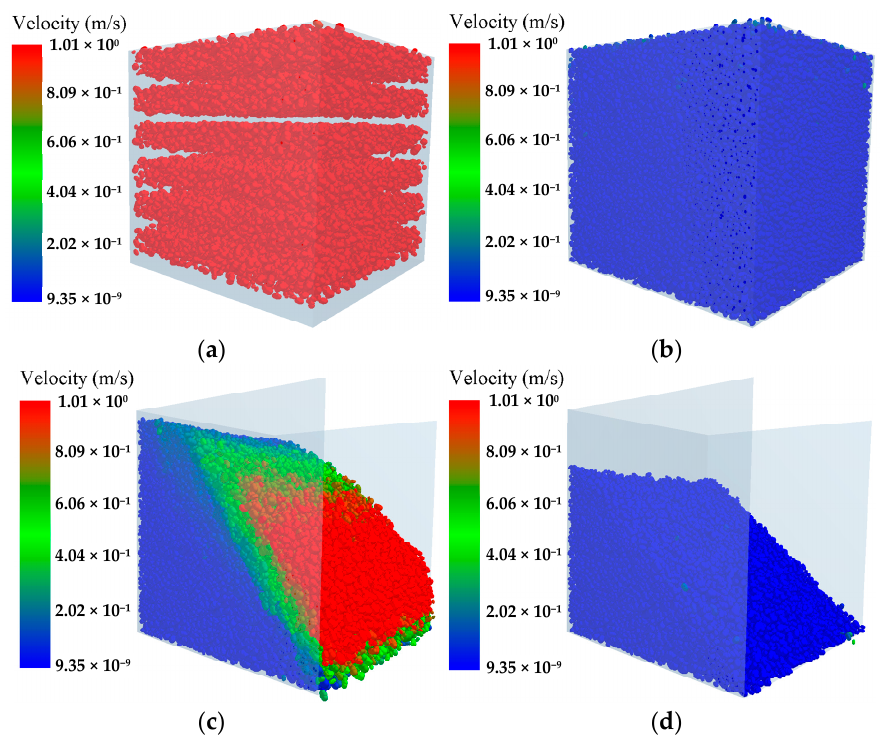
Figure 7. The simulation process of the natural accumulation surface of the materials: ( a ) Material filling process; ( b ) Material stabilization process; ( c ) Free slipping process; ( d ) Material stops slipping.